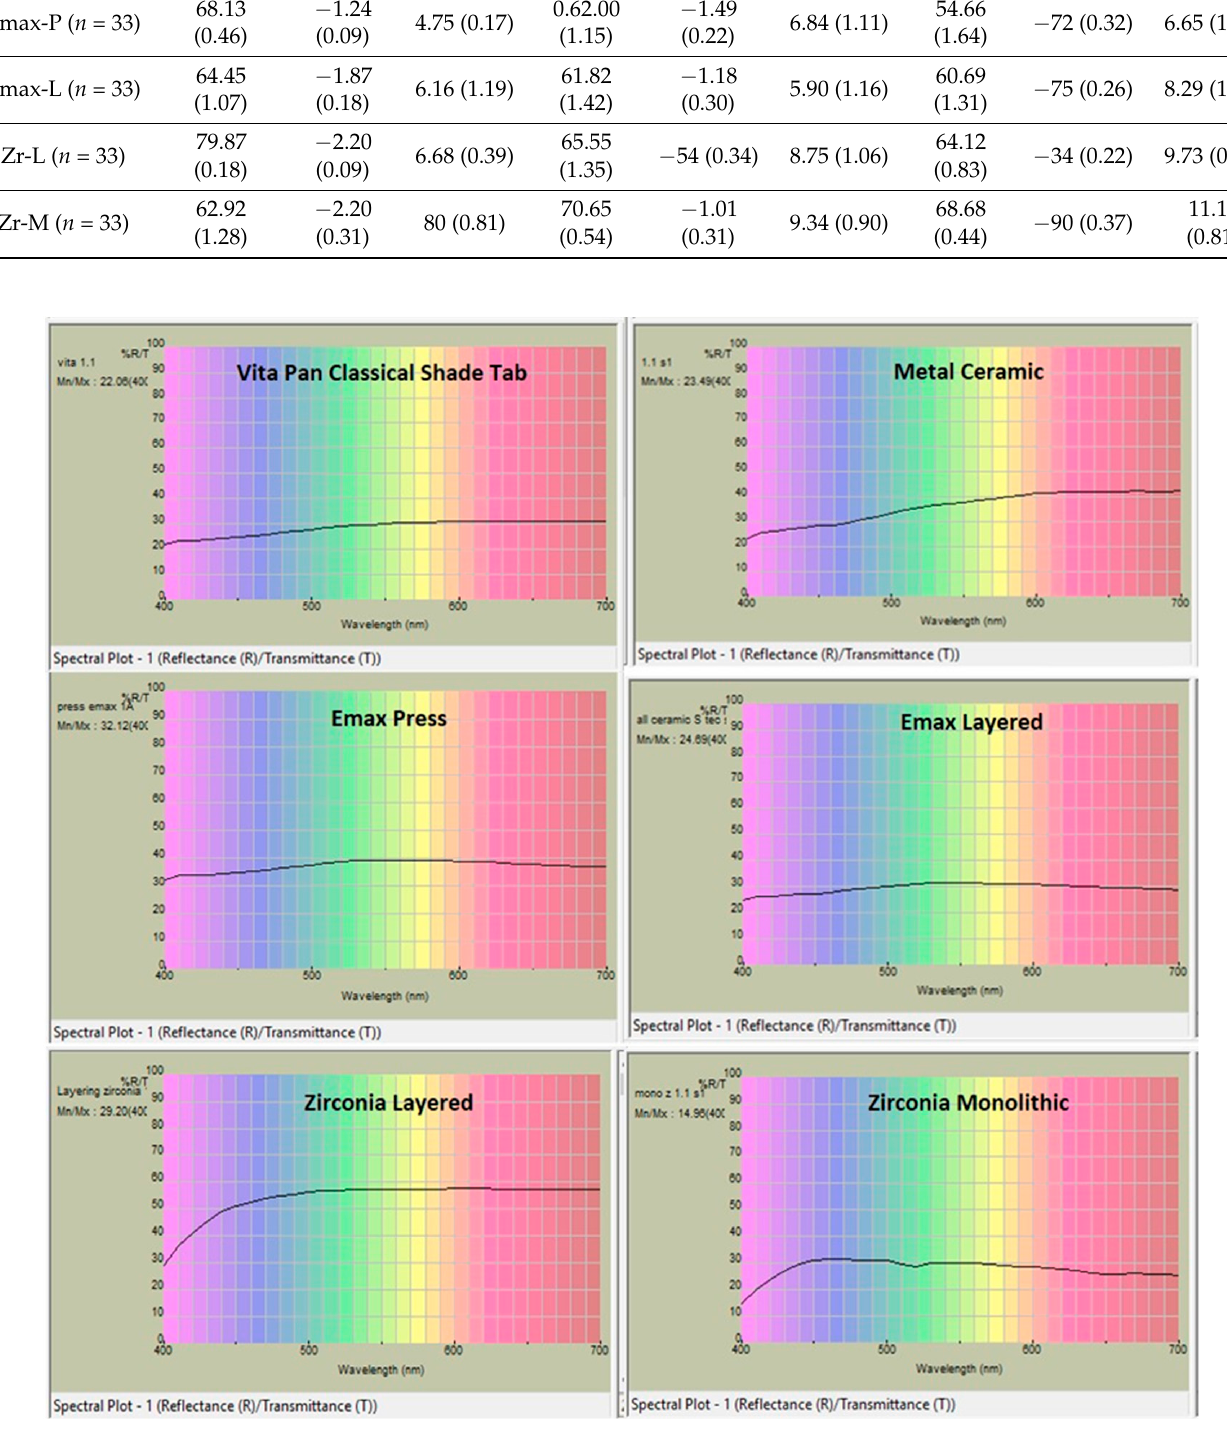
Figure 1. Spectral plot showing the L* a* b* values of the five tested ceramic materials and vita-pan shade tab, obtained from the spectrophotometer. Table 3. Mean and standard deviation of the delta E ( Δ E) of the tested ceramic materials ( N = 165).